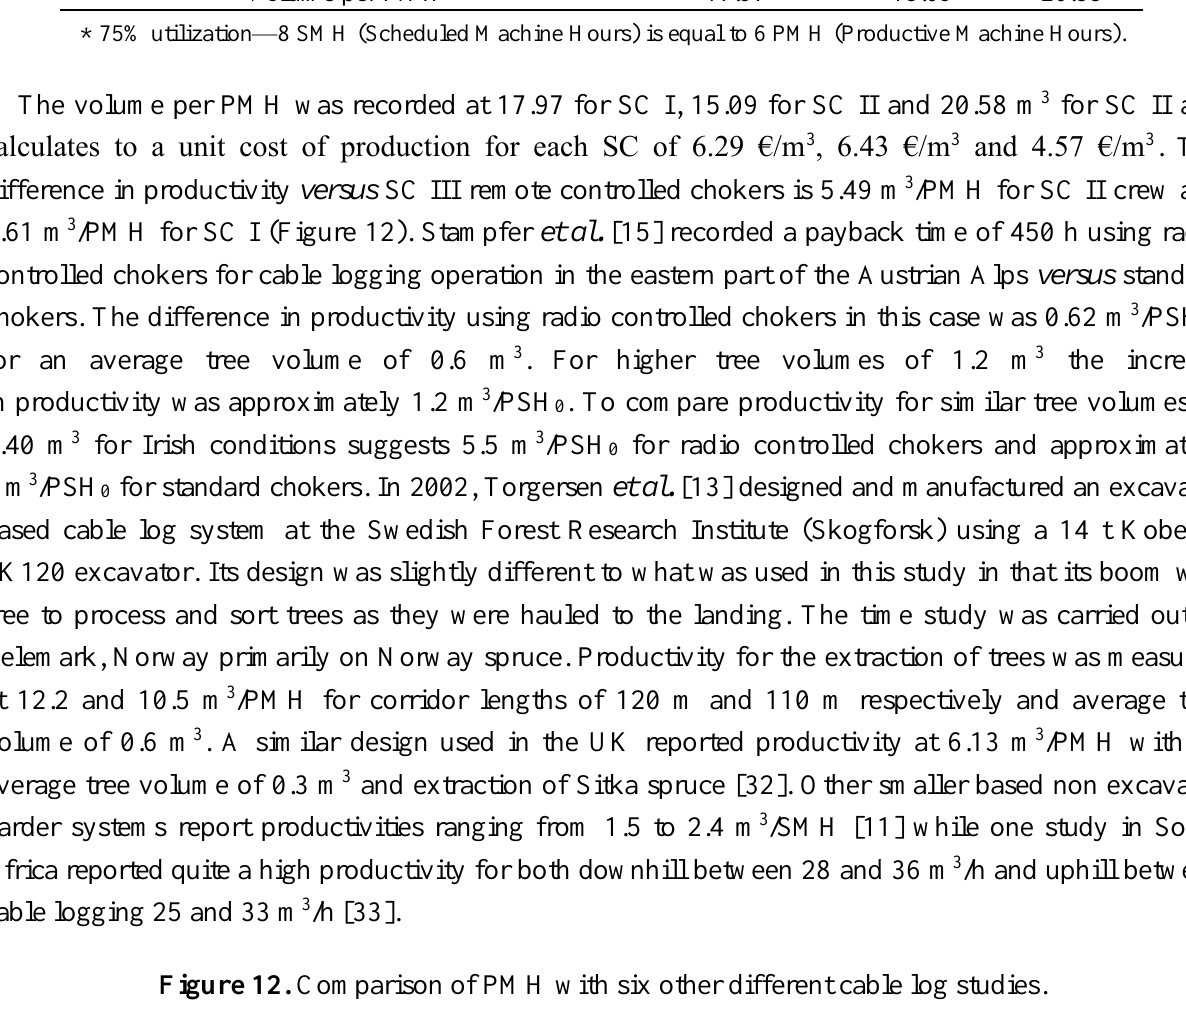
Figure 12. Comparison of PMH with six other different cable log